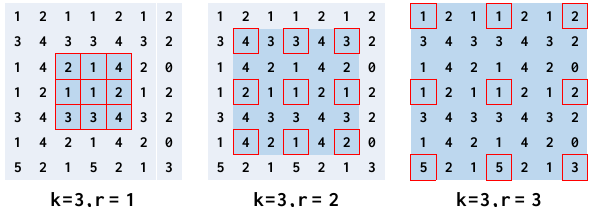
Figure 1. Convolutional layer with different dilated rates. Region covered in dark blue indicates the receptive field. When r = 1, the RF size of a 3 × 3 convolutional filter is equal to 3. When r = 2, the RF size increase to 5. When r = 3, the RF size is equal to